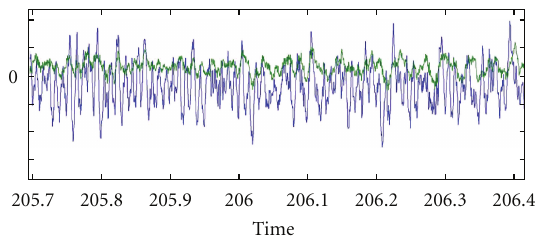
Figure 10: Temporal signals of F y and F z with low pass filter (cut- o ff frequency 100 Hz), Q n , 1.2 N ref .